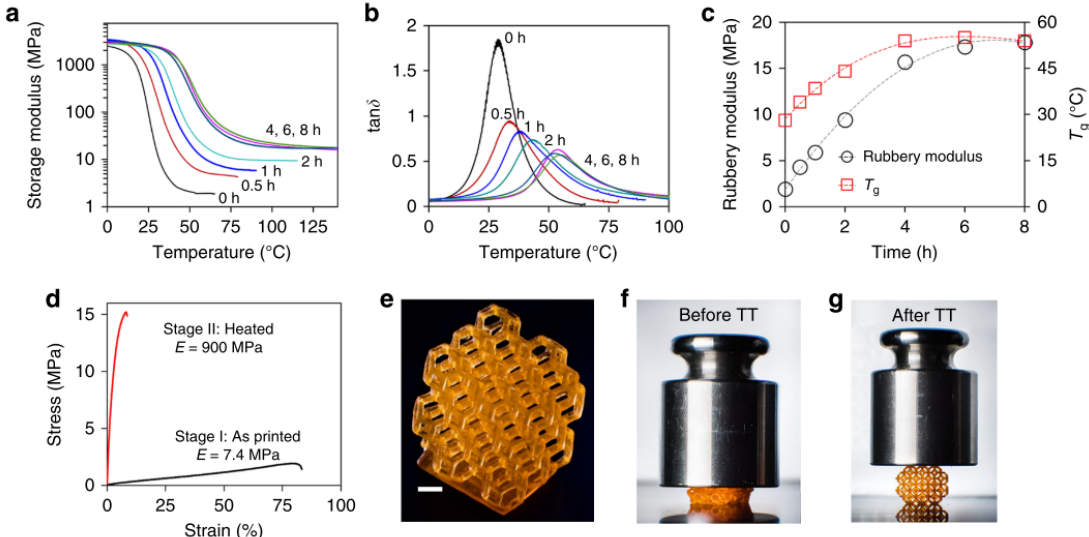
Figure 18. Demonstration of changes in stiffness of 3D printed thermosets produced in [79], caused by transesterification reactions leading to network structure rearrangement. ( a – c ) Dynamic mechanical analysis (DMA) showing the effect of the thermal treatment on the mechanical properties of samples. ( d ) Uniaxial tensile tests of printed samples before and after the 4 h thermal treatment at 180 °C. Demonstration of stiffness change of a printed Kelvin foam ( e ), before ( f ), and after ( g ) thermal treatment (TT) at 160 °C for 12 h. Adapted from [79], published under CC BY 4.0 license.